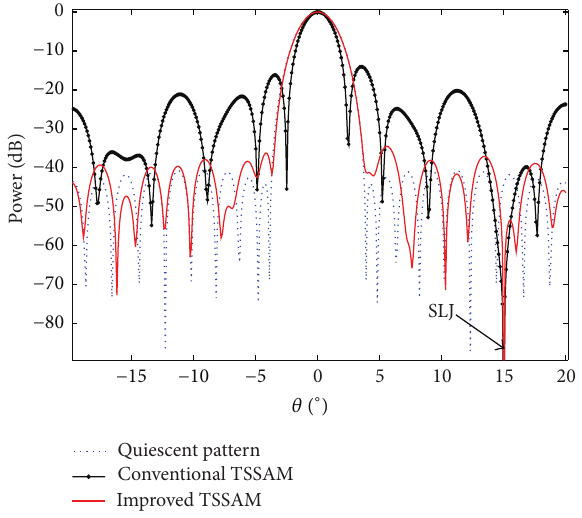
Figure 16: Adaptive patterns of elevation sum beam obtained by first-stage adaptive processing.